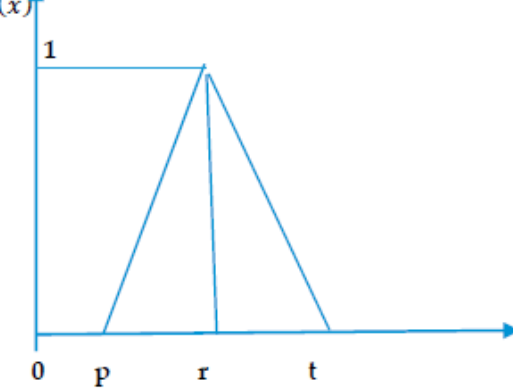
Figure 2. Diagram representing Triangular Fuzzy Number (TFN), 𝑆̃ = (𝑝,𝑟,𝑡)